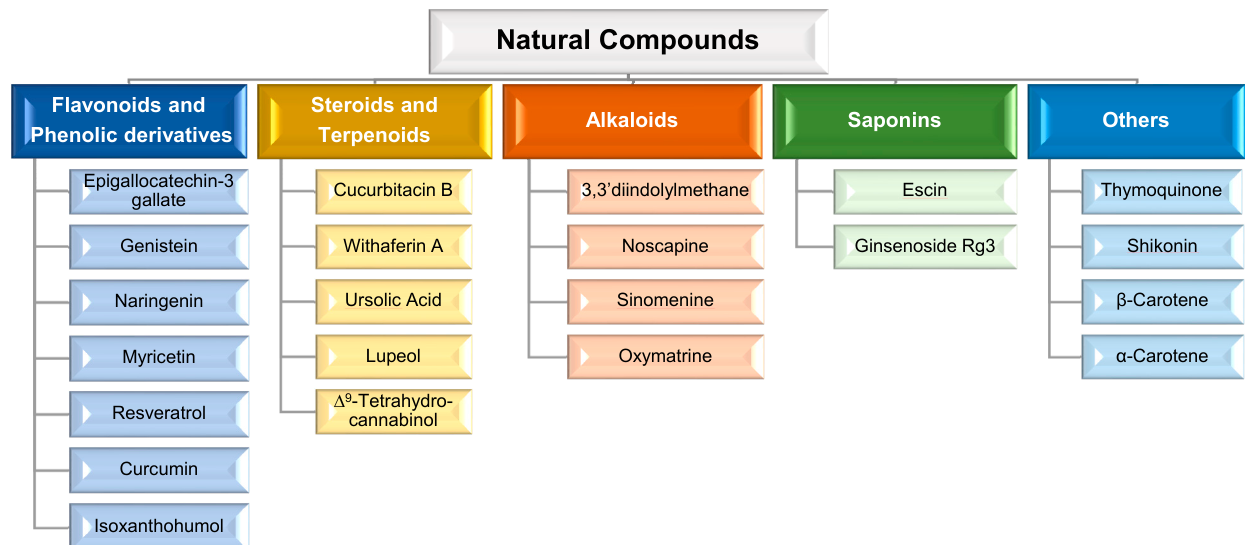
Figure 3. Main natural compounds considered chemosensitizing agents, according to their chemical family [47] .